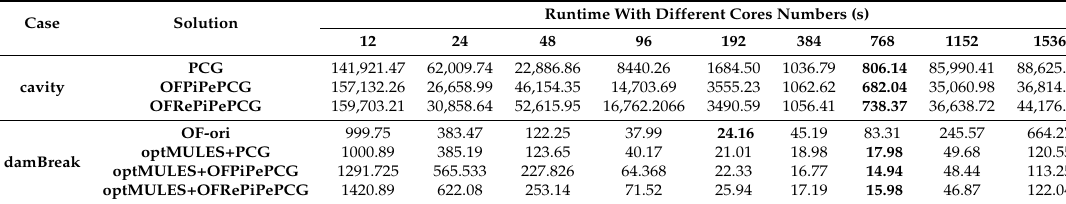
Table 8. Results of strong scaling